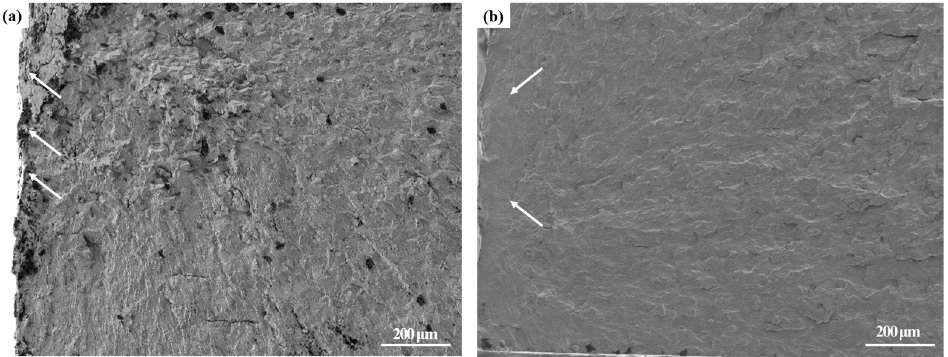
Figure 8. Fatigue fracture morphology of samples. ( a )as-received; ( b )HESPed.